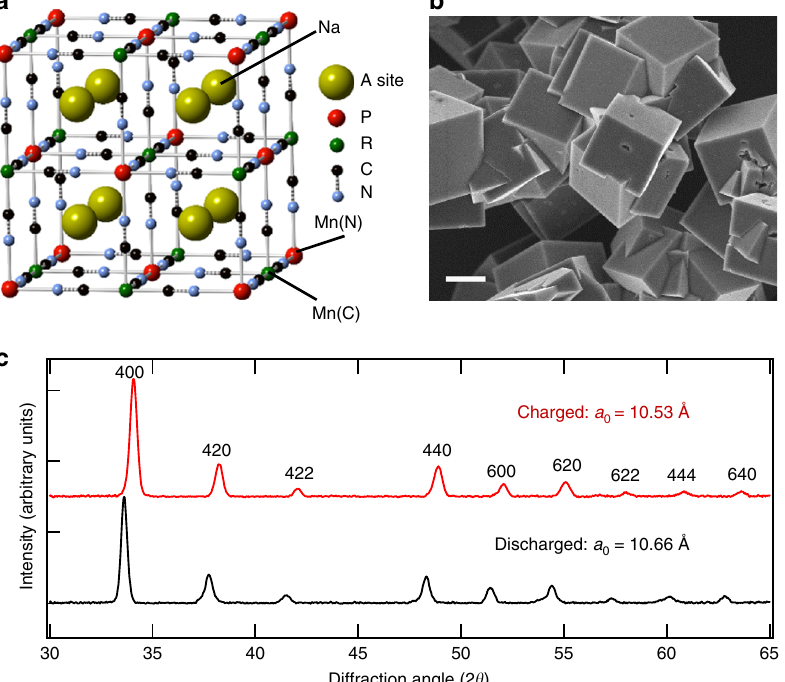
Fig. 1 Structure of Mn-based PBA, MnHCMn, materials. a The unit cell of PBAs, in which transition-metal cations are octahedrally coordinated to C-N ligands in a cubic framework. The interstitial A sites store the alkali cations that are electrochemically intercalated and the zeolitic water. b A scanning electron micrograph of the as-synthesized MnHCMn material. Scale bar is 1 µ m. c The powder X-ray diffraction spectra of a pristine (discharged) and charged MnHCMn electrodes. The cubic PBA structure is maintained throughout the electrochemical